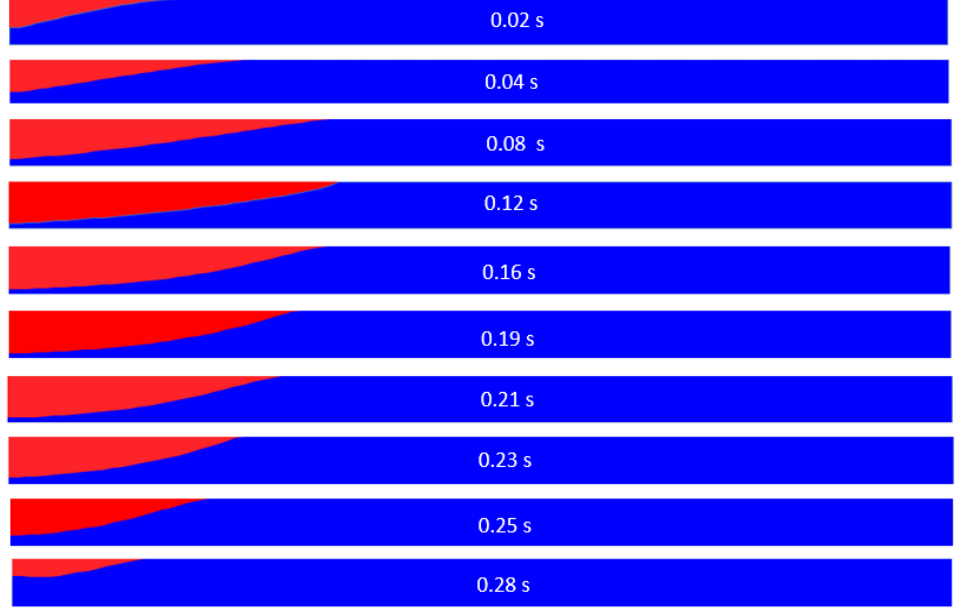
Figure 12. Cavity size evolution captured by MTPA.